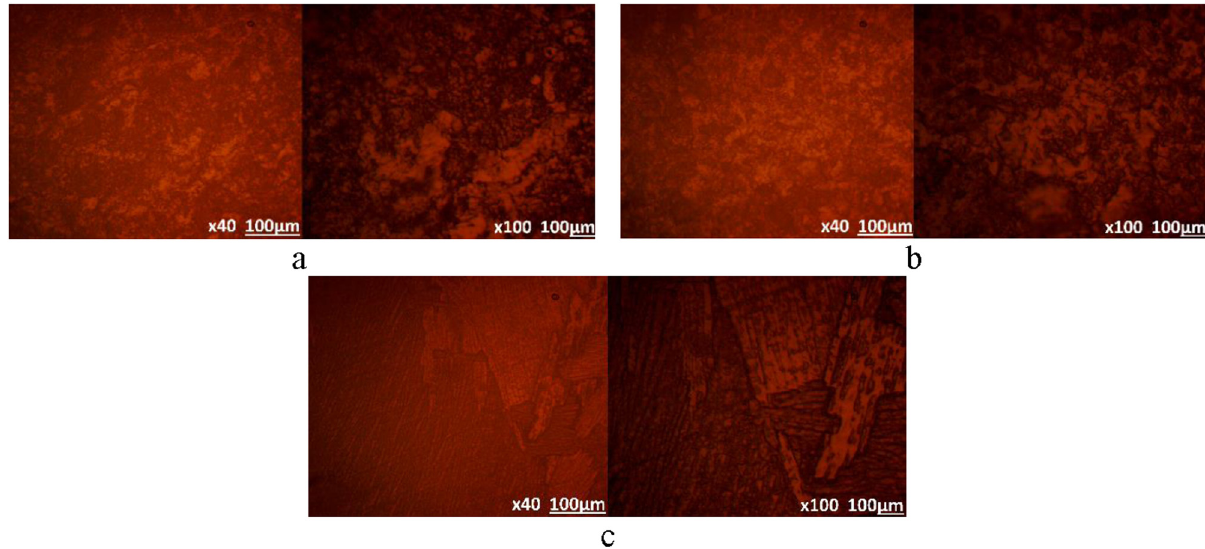
Figure 9: Optical images of ( a ) B265TiN, ( b ) B265TiQ, and ( c ) B265TiA after corrosion test in 6 M H 2 SO 4 + 10% NaCl at 70°C.